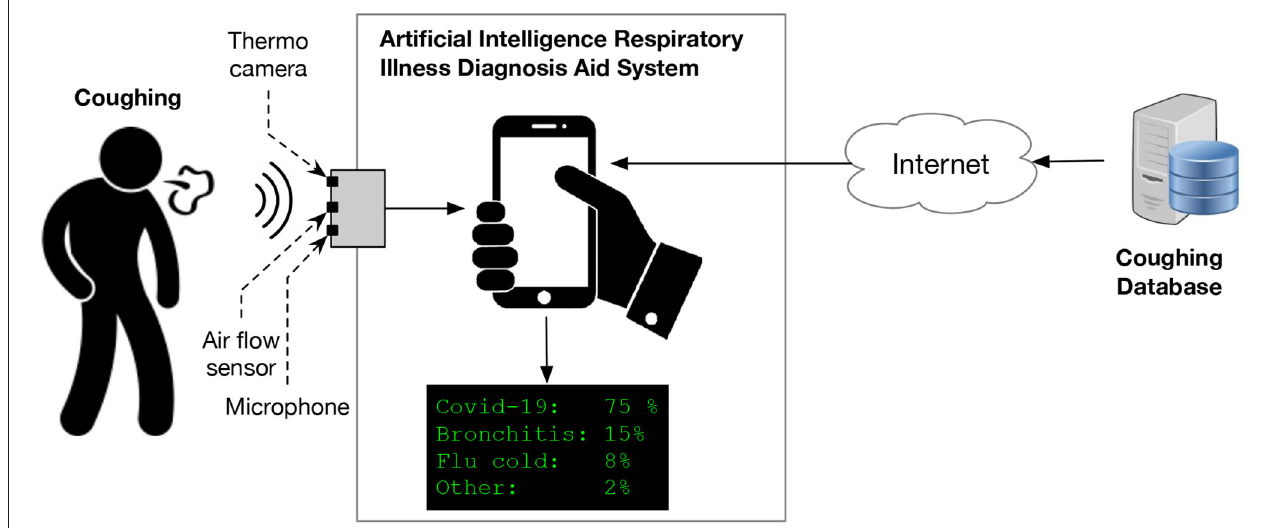
FIGURE 1 | Illustration of the proposed AI-based diagnosis aid system for simultaneously recording, detecting, and classifying cough characteristics using fuzzy logic